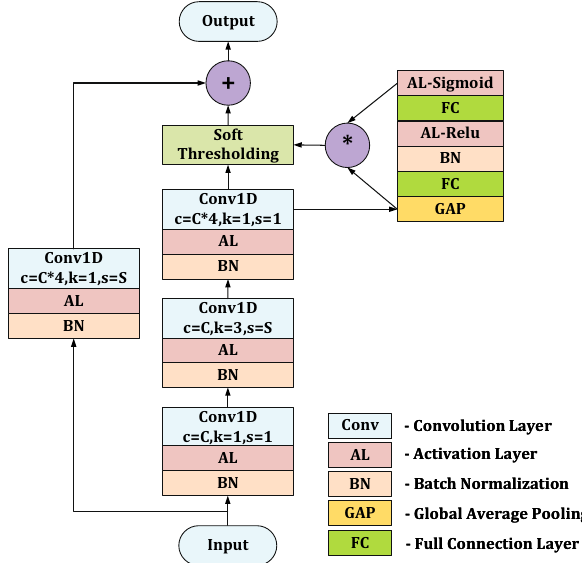
Figure 1. The basic unit of DRSN 47 . In convolution layer, parameter c is the convolutional out channel number, k is the kernel size of convolution, and s is the stride of